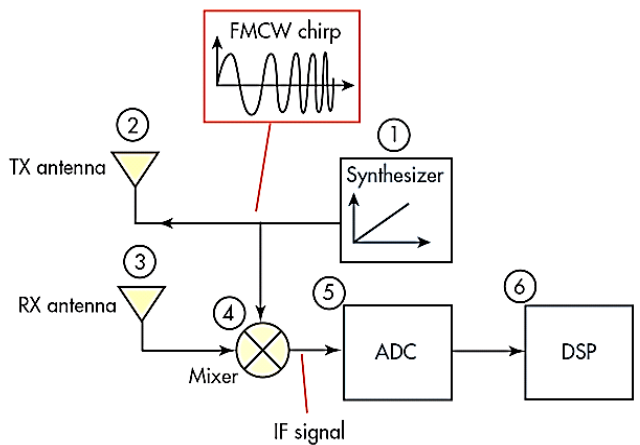
Figure 21. Chirp short-range radar scheme.